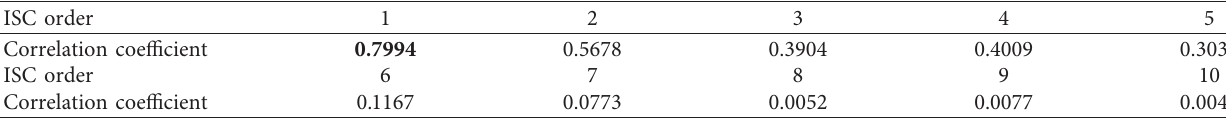
Figure 9: LCD decomposition results of x-channel under normal conditions. Table 3: Correlation coefficients of ISCs of each order under normal conditions.